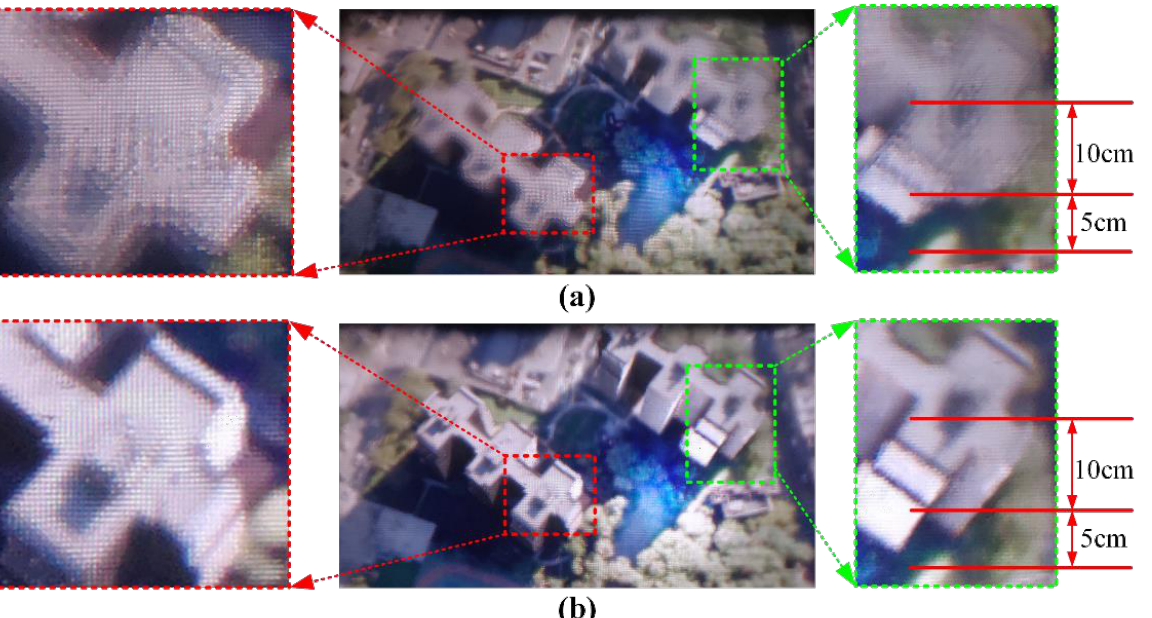
Table 1. The specific parameters of tabletop 360-degree 3D light-field display system. Parameter Detail